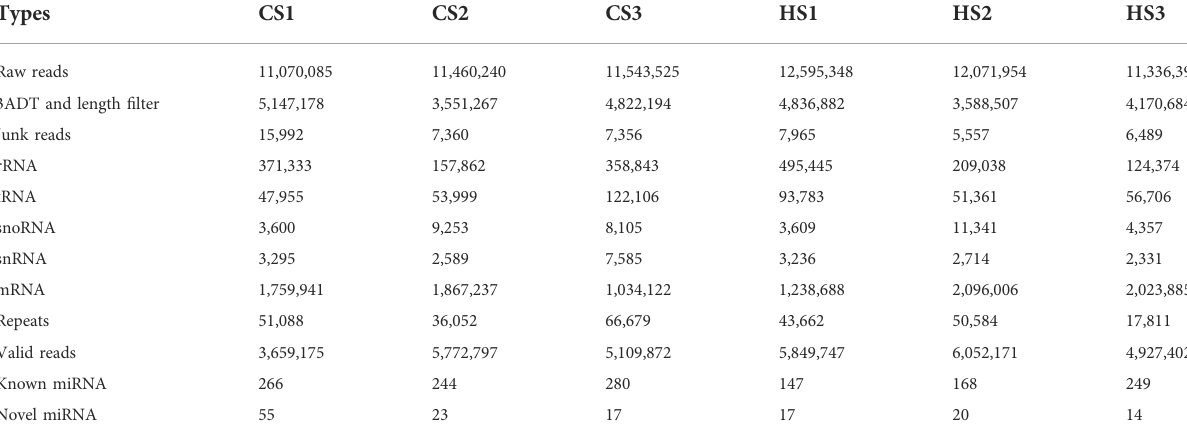
TABLE 2 Statistics of small RNA sequences from the six libraries in the body wall of Apostichopus japonicas .